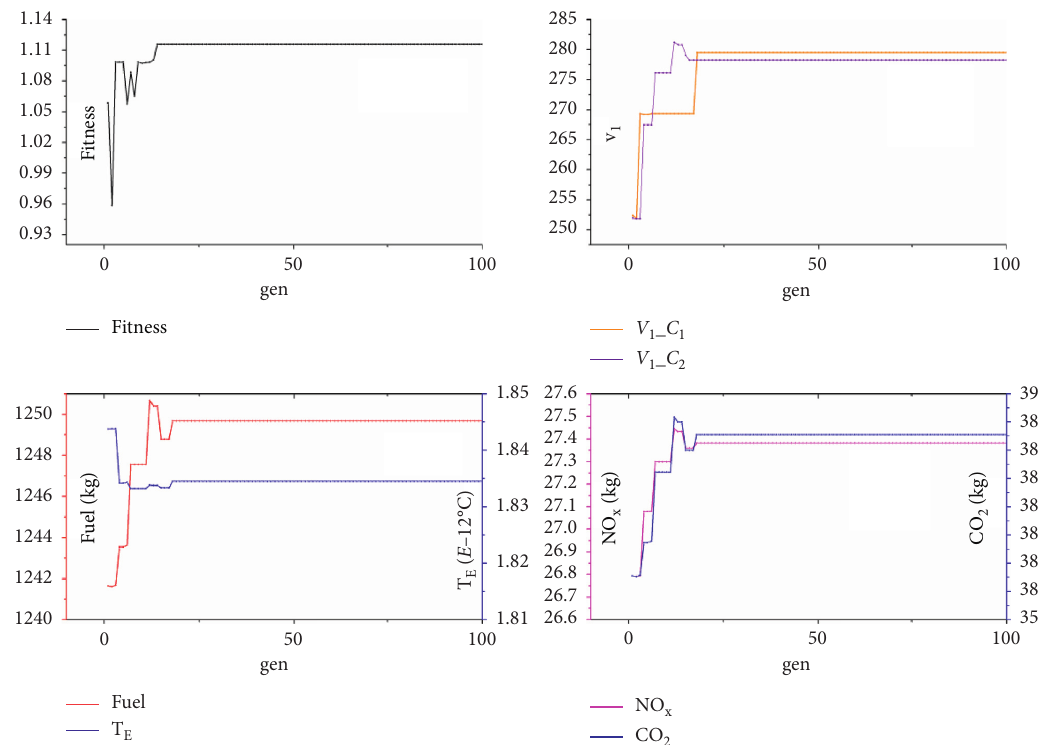
Figure 9: Optimize parameters when w